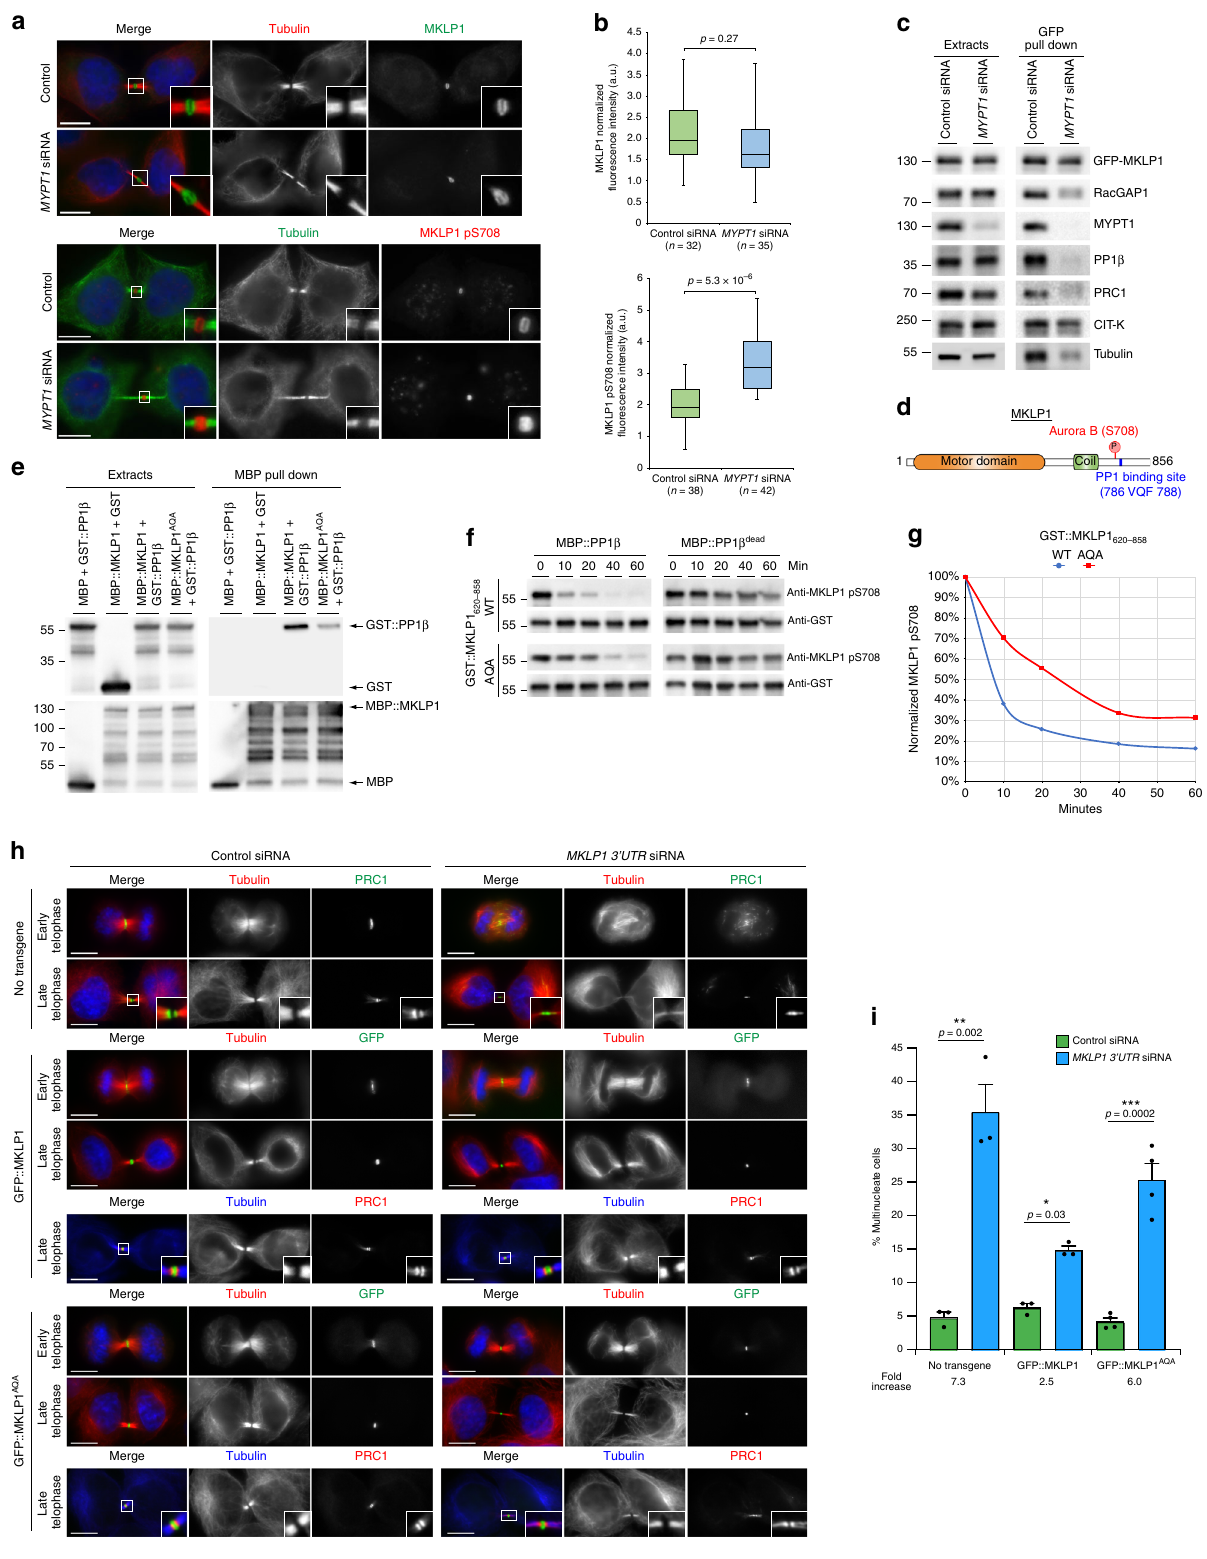
Af fi nity puri fi cation (AP) . For large-scale AP of GFP-tagged proteins and asso- ciated partners, cells were plated at 1/6 con fl uence in either six 175cm 2 fl asks or in two three-layer 525 cm 2 tissue culture fl asks (BD Biosciences) and after 24h synchronized at different stages of the cell cycle as described in the previous section, collected, washed in PBS and cell pellets stored at − 80 °C. Each cell pellet was resuspended in 5ml of lysis buffer (20 mM Tris-HCl, 150 mM NaCl, 2mM MgCl 2 , 1 mM EGTA, 0.1% [v/v] NP-40, 1mM DTT, 5% [v/v] glycerol and Roche